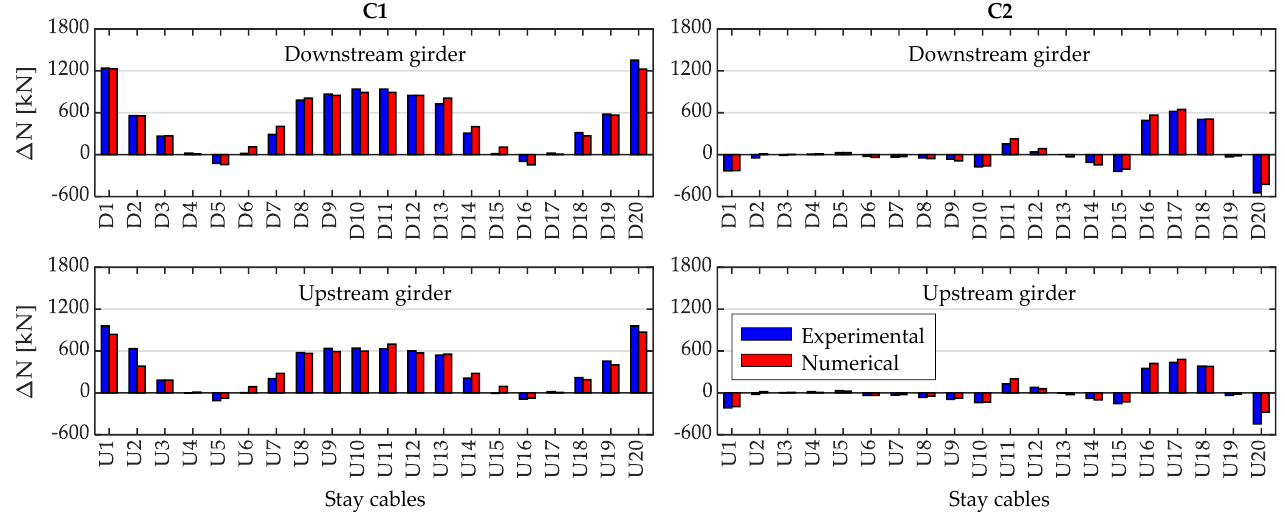
Figure 10. Increase/decrease of the stay cable axial loads for C1 and C2 with respect to the U 0 con-